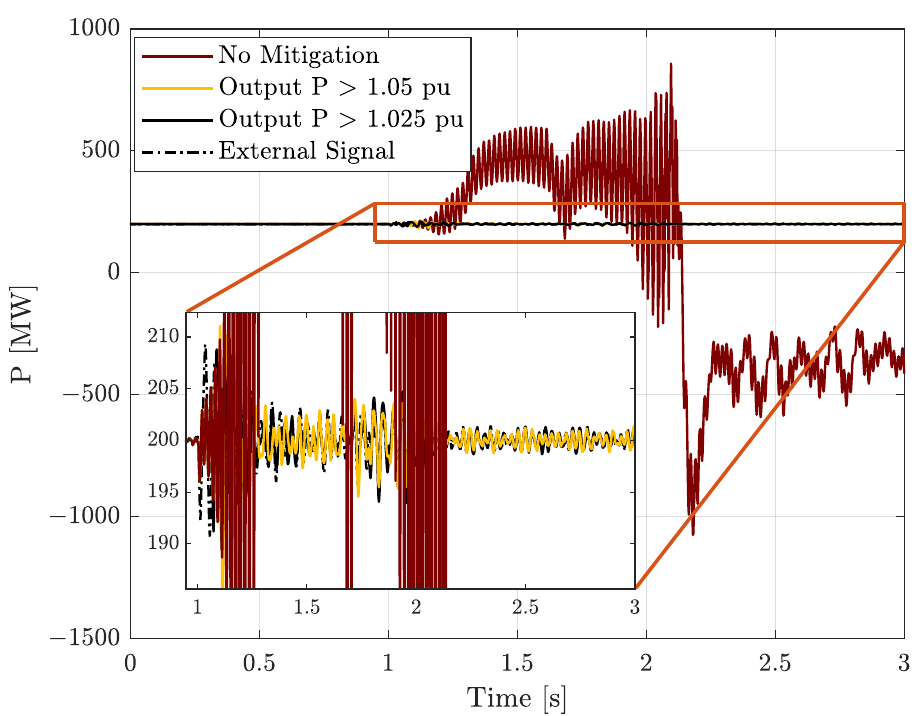
Figure 10. Comparison between no mitigation operation and the three mitigation approaches. Oscillations grow to 500 MW in 0.5 s without any